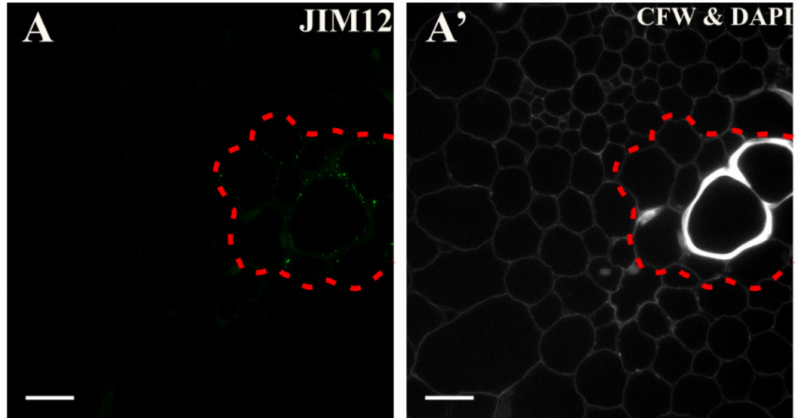
Figure 12. Distribution of the extensin epitope that is detected by the JIM12 antibody ( A ) Fragment of the hypocotyl vascular bundle. A punctate signal in the cell wall of the xylem elements was visible (area marked with a dashed line). ( A’ ) Calcofluor white (CFW) and DAPI staining of the section shown on A. Scale bars: A , A’ —10 µ